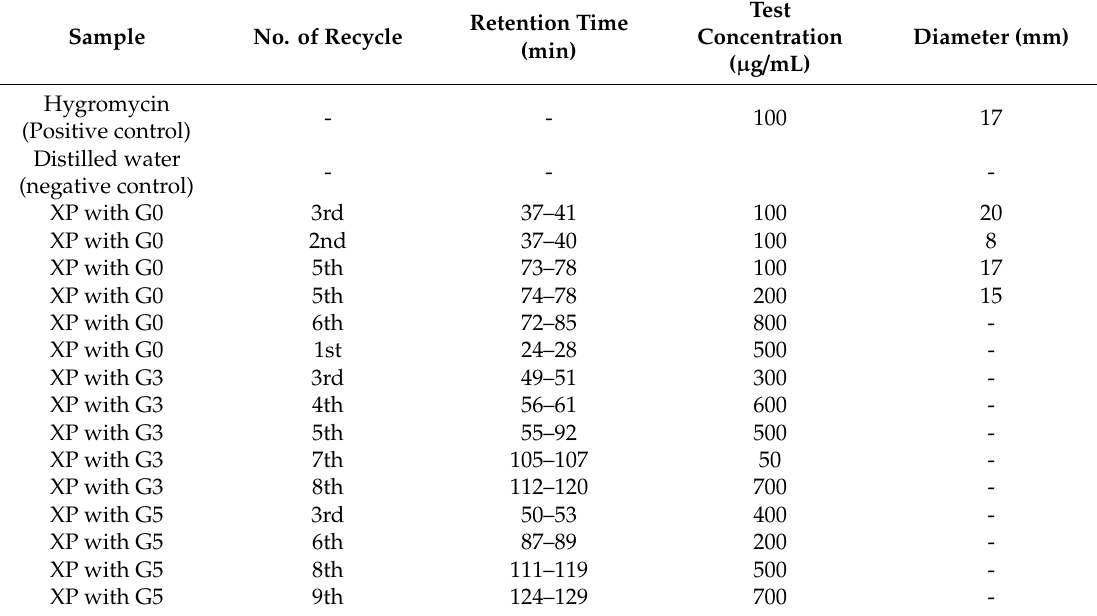
Table 1. Growth inhibition zone in mm indicates the antifungal activities of recycling preparative High Performance Liquid Chromatography (HPLC) fractions against Ganoderma